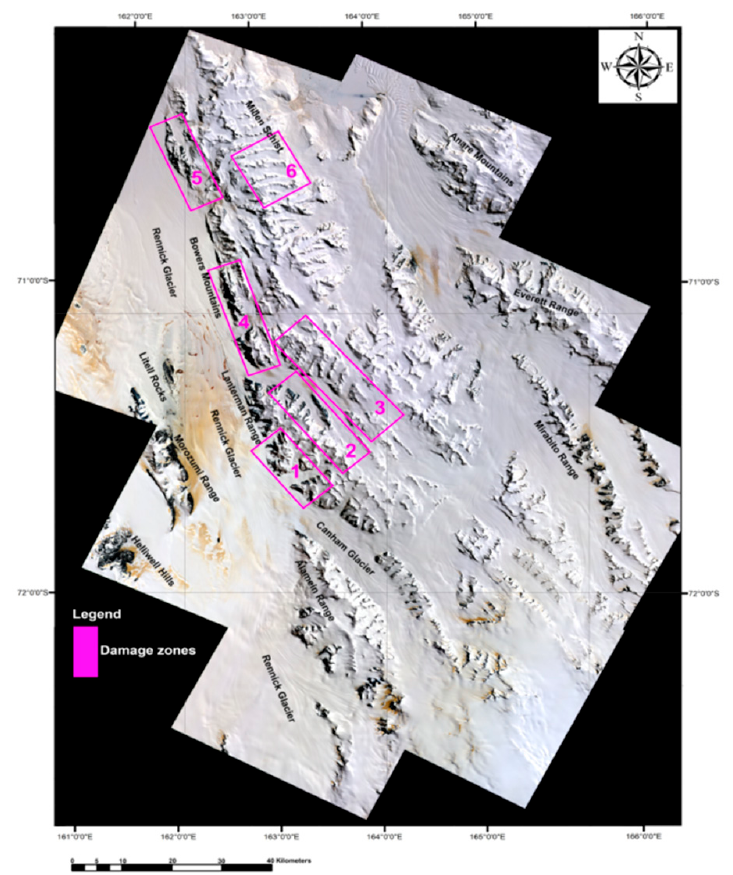
Figure 3. ASTER mosaic of the Bowers Terrane (BT) and surrounding area (the coverage of ASTER images used in this study). Magenta rectangles indicate selected subsets of fault zones (zones 1–6) for detailed mineral mapping.